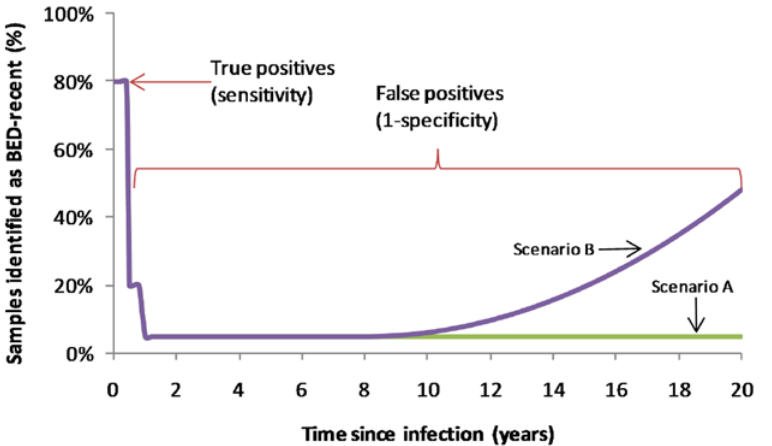
Figure 1. The influence of time since infection on the proportion of BED test results that would be positive. The pattern over the first year is informed by observational data, but pattern over the remaining time is uncertain and two hypothetical scenarios were used in our modelling (scenarios A and B).